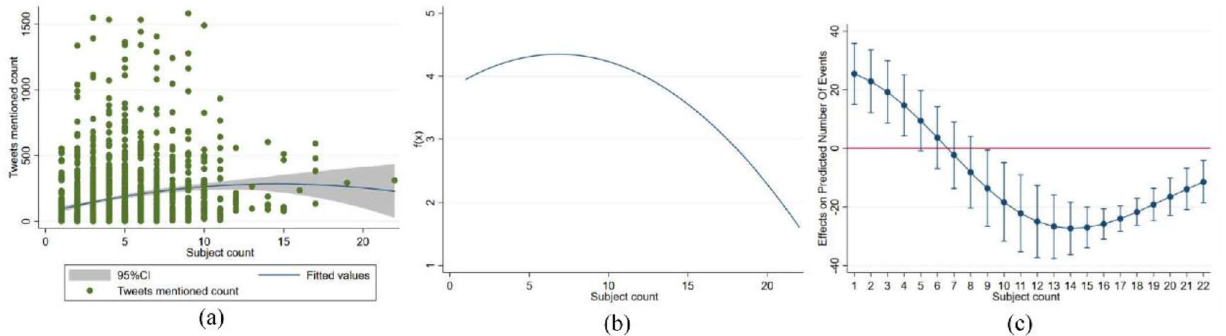
Figure 1. (a) Scatter plot and fitted curve of number of Tweets mentioned count vs. subject count (b) Regression function graph (c) Average marginal effects of subject count with 95%